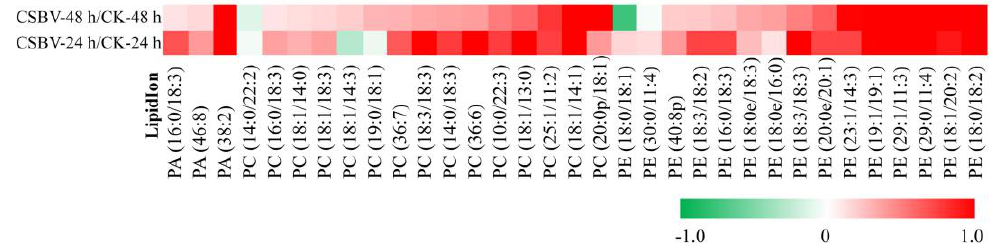
Figure 6. Heatmap of Log2 fold changes in phospholipids species following CSBV infection of A. c. cerana larvae on p .i. 24 h and p .i. 48 h arranged by putative ID subclasses.